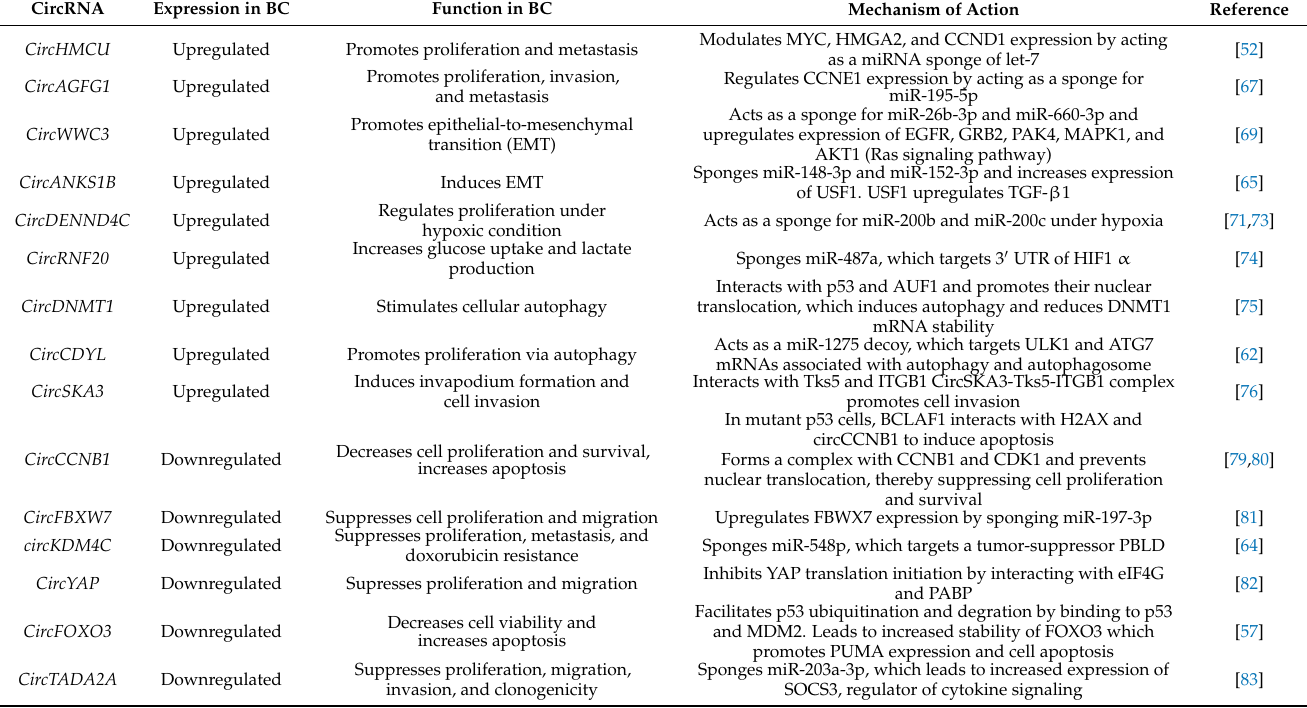
Table 1. CircRNAs involved in breast cancer